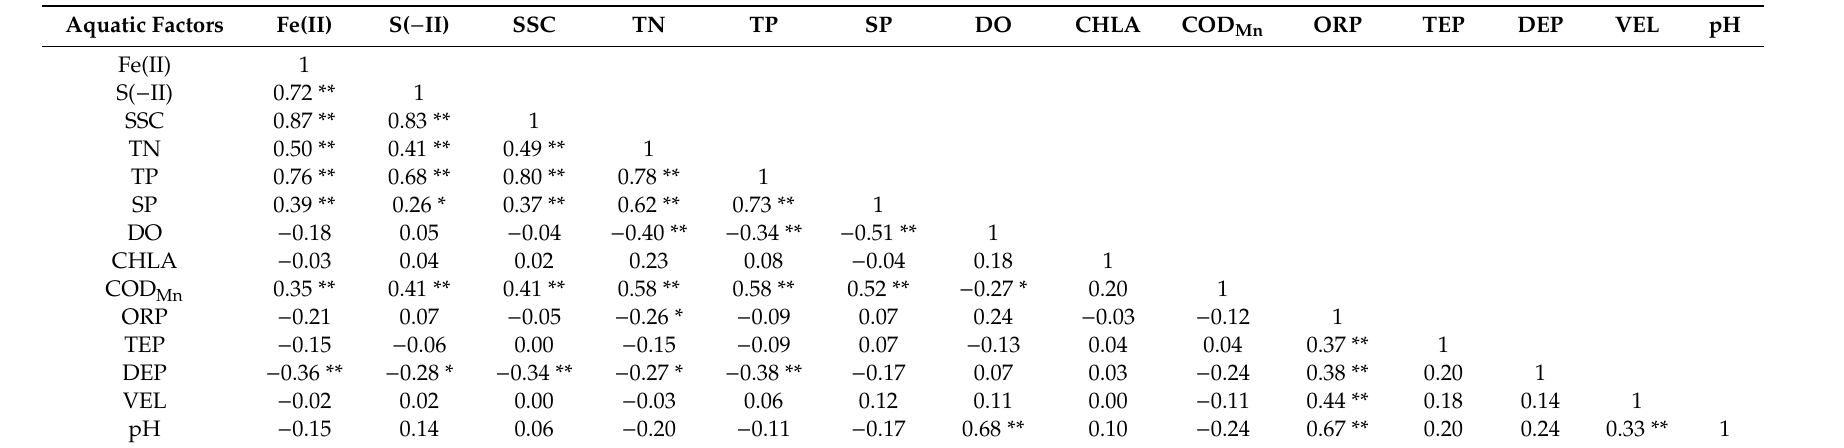
Table 2. Pearson correlation coe ffi